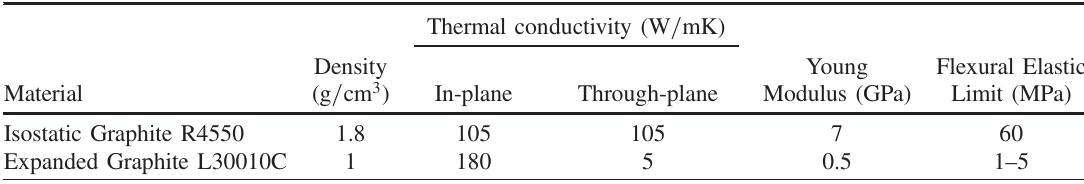
TABLE I. Comparison between properties (at room temperature) of conventional isostatic graphite (commercial grade R4550) and expanded graphite (commercial grade L30010C), both provided by the company SGL